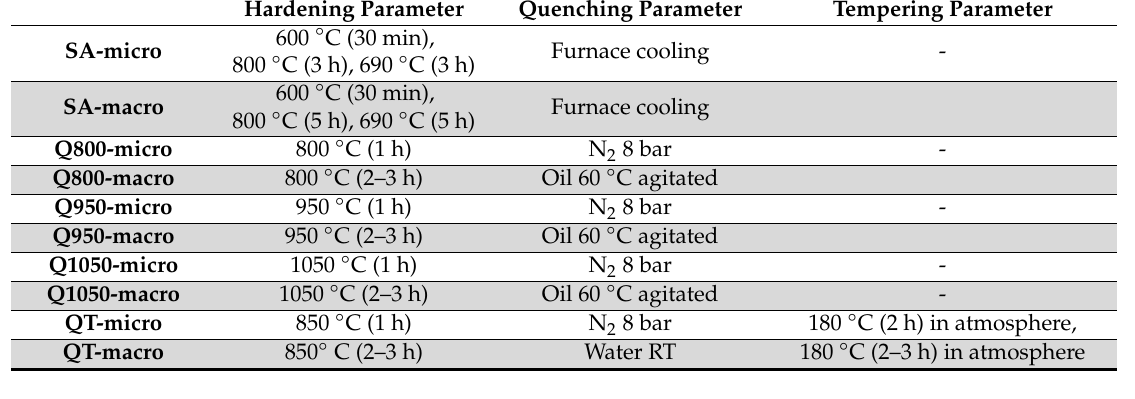
Table 3. Heat treatments (micro: microscopic particles, macro: macroscopic samples).